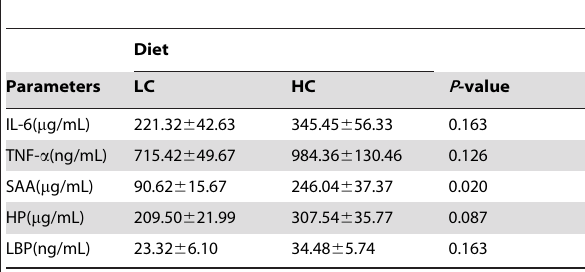
Table 4. Plasma cytokines and acute phase protein levels in control and treatment group